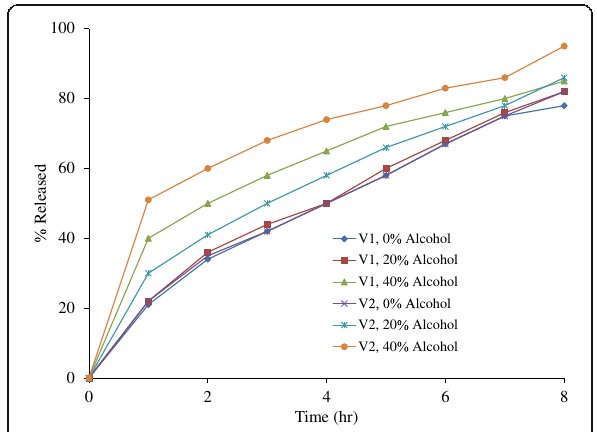
Fig. 26 Effect of alcohol on % drug released from two venlafaxine tablets (V1 and V2) (data from reference (Avachat & Nandare 2014))